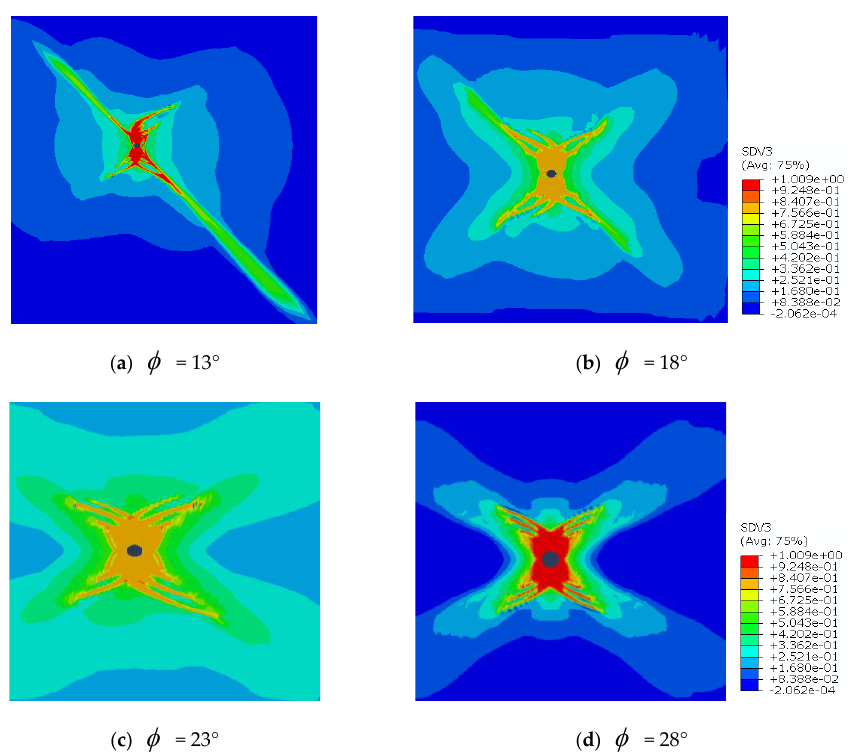
Figure 10. Evolution of disturbance damage factor with the internal friction angle of rock.